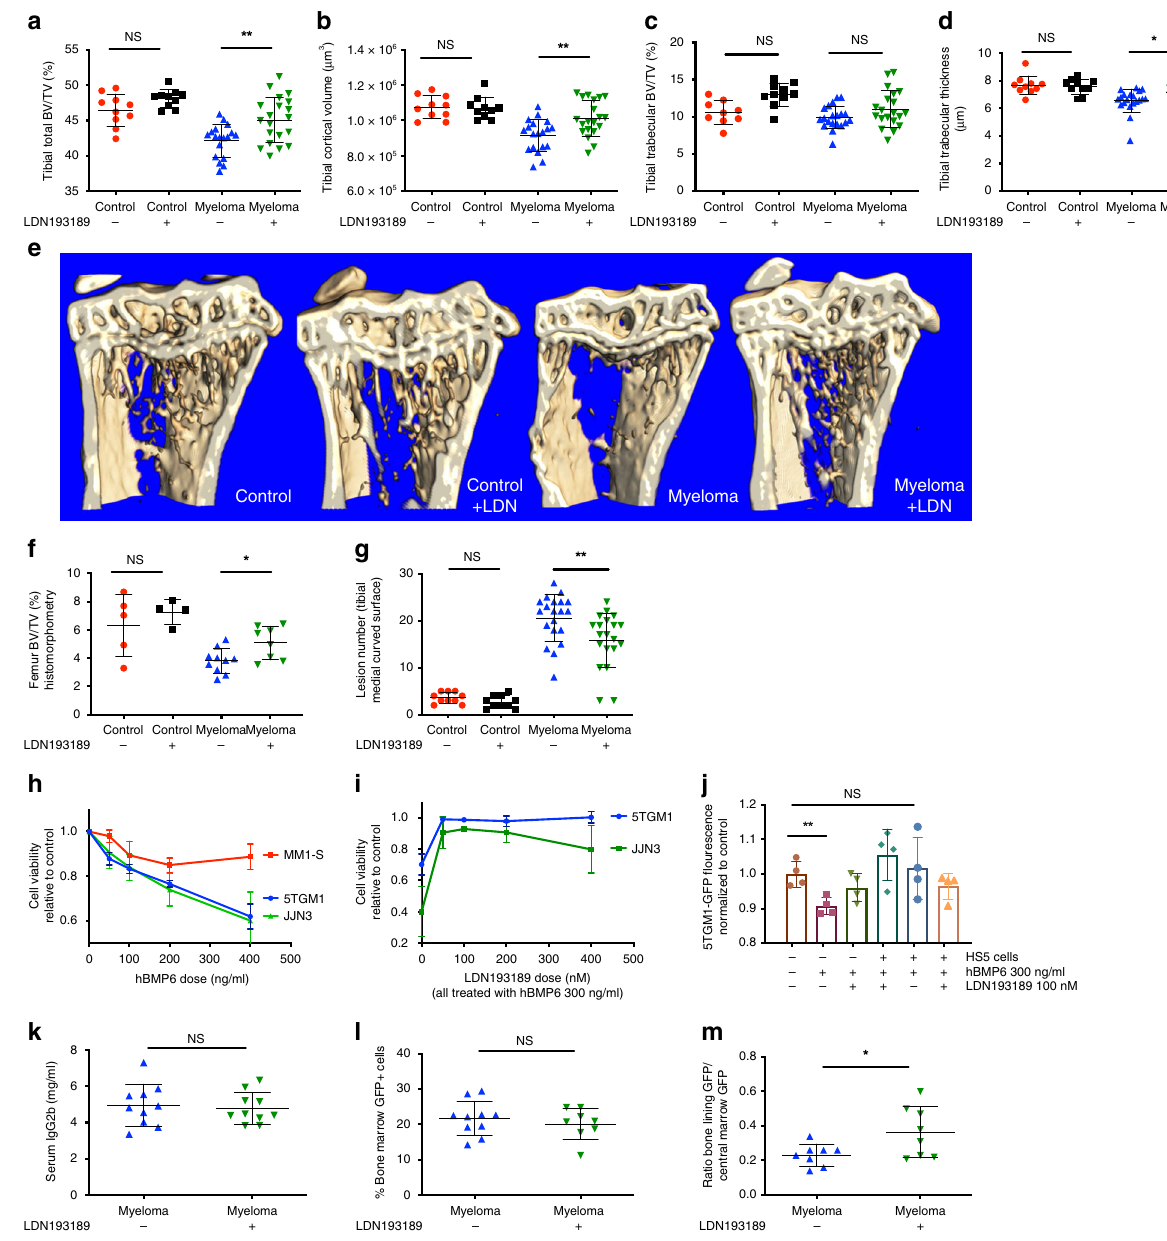
Fig. 2 Inhibition of BMP signalling with LDN193189 reduces myeloma bone disease in vivo, with no effect on tumour burden. n = 10 per control group, 20 per myeloma group, total n = 60 for microCT-derived indices; n = 5 per control group, 10 per myeloma group, total n = 30 for other indices. Missing data values: see Methods. * P < 0.05, ** p < 0.01, *** p < 0.001, NS, not signi fi cant, t test. Source data are provided as a Source Data fi le. Reconstructed